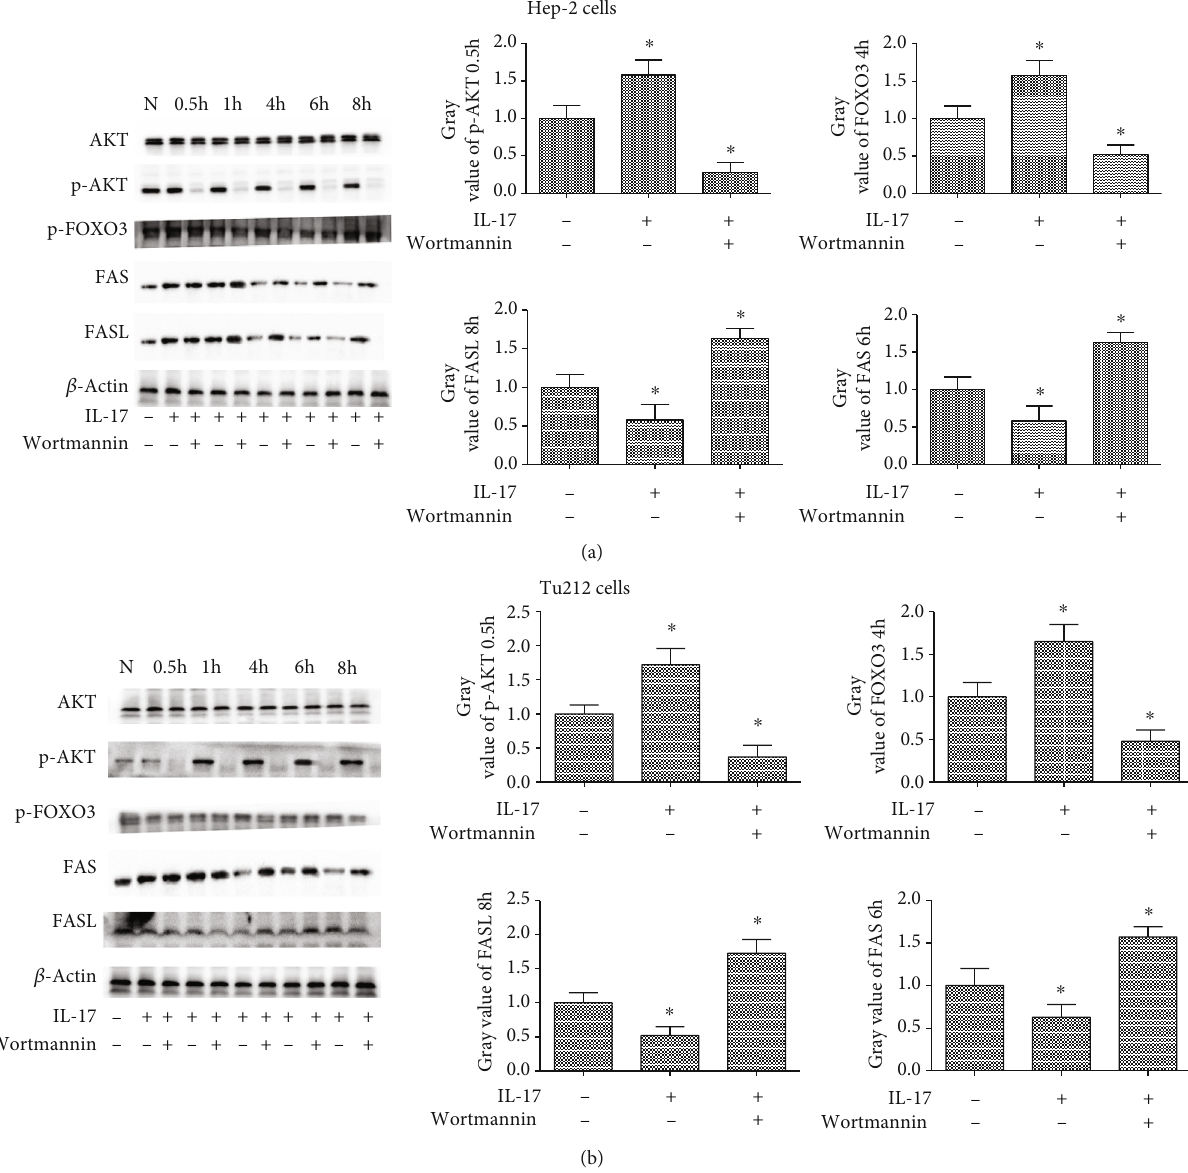
Figure 4: The 200-17-induced FAS and FASL phosphorylation was dependent on PI3K/AKT pathway activation in the LC cell lines. (a) AKT, phosphorylation of AKT, phosphorylated FOXO3, FAS, and FASL, as well as the gray intensity analysis in Hep-2 cells, stimulated with 200-17 for 0.5 h, 1h, 4 h, 6h, and 8 h, following pretreatment with wortmannin for 0.5h. (b) AKT, phosphorylation of AKT, phosphorylated FOXO3, FAS, and FASL, as well as the gray intensity analysis in Tu212 cells, stimulated with 200-17 for 0.5h, 1h, 4 h, 6h, and 8h, following pretreatment with wortmannin for 0.5h. n = 3 per group. One representative experiment of the three independent experiments is demonstrated. ∗ P < 0 : 01 versus the